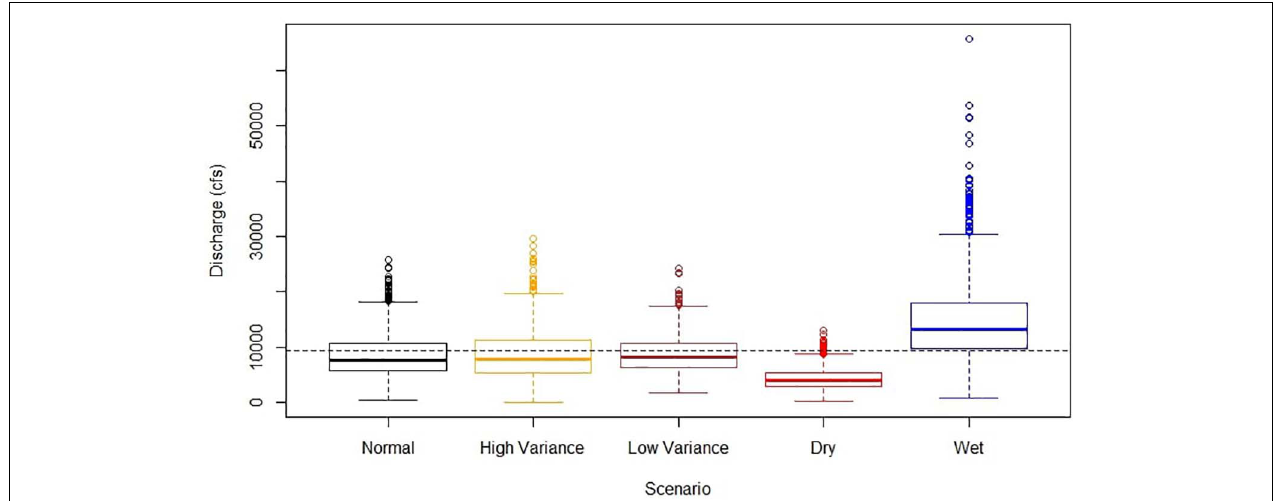
FIGURE 2 | Projected monthly discharge from the short-term simulations. High and low variance scenarios were created by multiplying the random component of these simulations by 30%. Dry and wet scenarios were created by adding or subtracting mean discharge by one standard